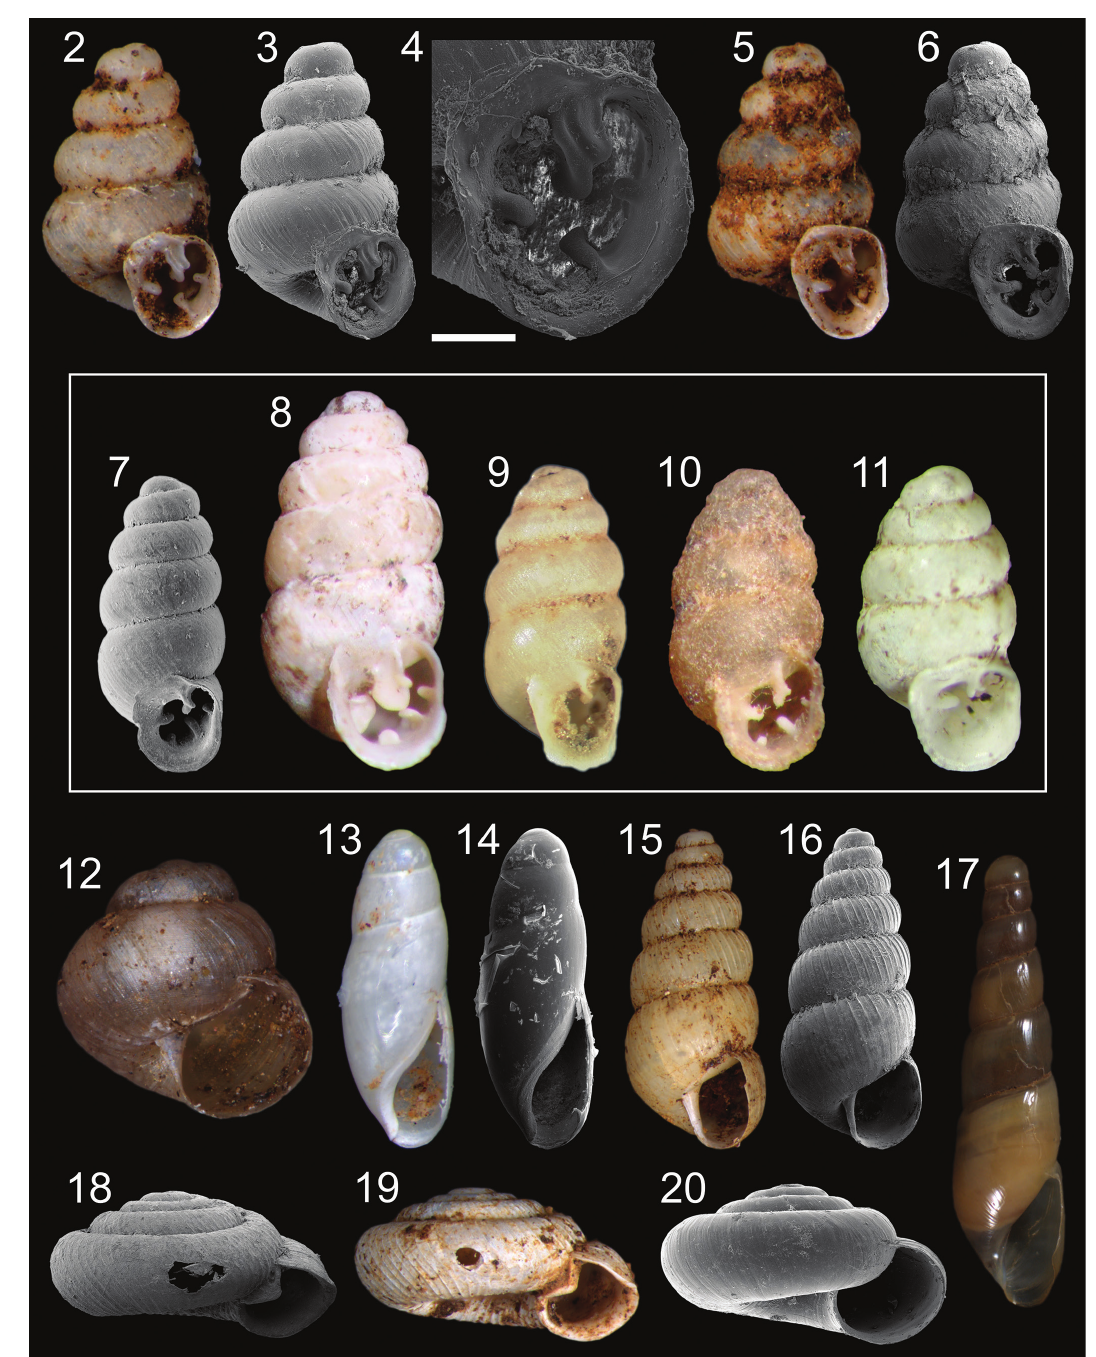
Figures 2–20. Gastrocopta sharae sp. n., holotype (MZSP 122725, H = 1.9 mm, D = 1.1 mm). 2. Apertural view; 3. Apertural view, SEM image; 4. Close-up of the aperture, showing dentition; scale bar = 200 μ m. 5–6. Gastrocopta sharae sp. n., paratype (MZSP 122726, H = 1.9 mm, D = 1.1 mm). 5. Apertural view; 6. Apertural view, SEM image. 7–11. Other Gastrocopta spp. from Brazil, shown in apertural view. All images in scale to one another and to G. sharae (Figs 2, 3, 5, 6). 7. G. barbadensis , from Trindade Island, SEM image (MZSP 104736, H = 1.9 mm); 8. G. iheringi , probable syntype, from Bolacha, Rio Grande do Sul state (MZSP 7519, H = 2.5 mm); 9. G. oblonga , from Brazil, precise provenance unknown (NMSW unnumbered, H = 2 mm); 10. Gastrocopta servilis , from Fortaleza, Ceará state (MZSP 7520, H = 2 mm); 11. Gastrocopta solitaria , possible holotype, from Fernando de No- ronha Archipelago (NHMUK unnumbered, H = 2 mm). 12. Pupisoma dioscoricola , apertural view (MZSP 131101, H = 1.6 mm, D = 1.6 mm). 13–14. Cecilioides consobrina (MZSP 131579, H = 1.9 mm, D = 0.6 mm). 13. Apertural view; 14. Apertural view, SEM image. 15–16. Dysopeas muibum (MZSP 131100, H = 5.4 mm, D = 2.3 mm). 15. Apertural view; 16. Apertural view, SEM image. 17. Stenogyra octogyra , apertural view (MZSP 122731, H = 14.3 mm, D = 3.7 mm). 18–19. Entodina jekylli (MZSP 131092, H = 1.6 mm, D = 3.1 mm). 18. Apertural view, SEM image; 19. Apertural view. 20. Prohappia besckei , apertural view, SEM image (MZSP 131096, H = 1.0 mm, D = 1.8